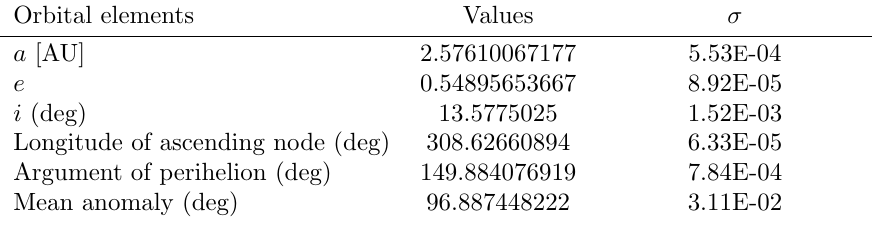
Table 3. Computed orbital elements of 2010 BT3. 96 observations are used, covering 41 days (2010 January 23.10902 – 2010 March 05.34983), r.m.s. = 0.640 ′′